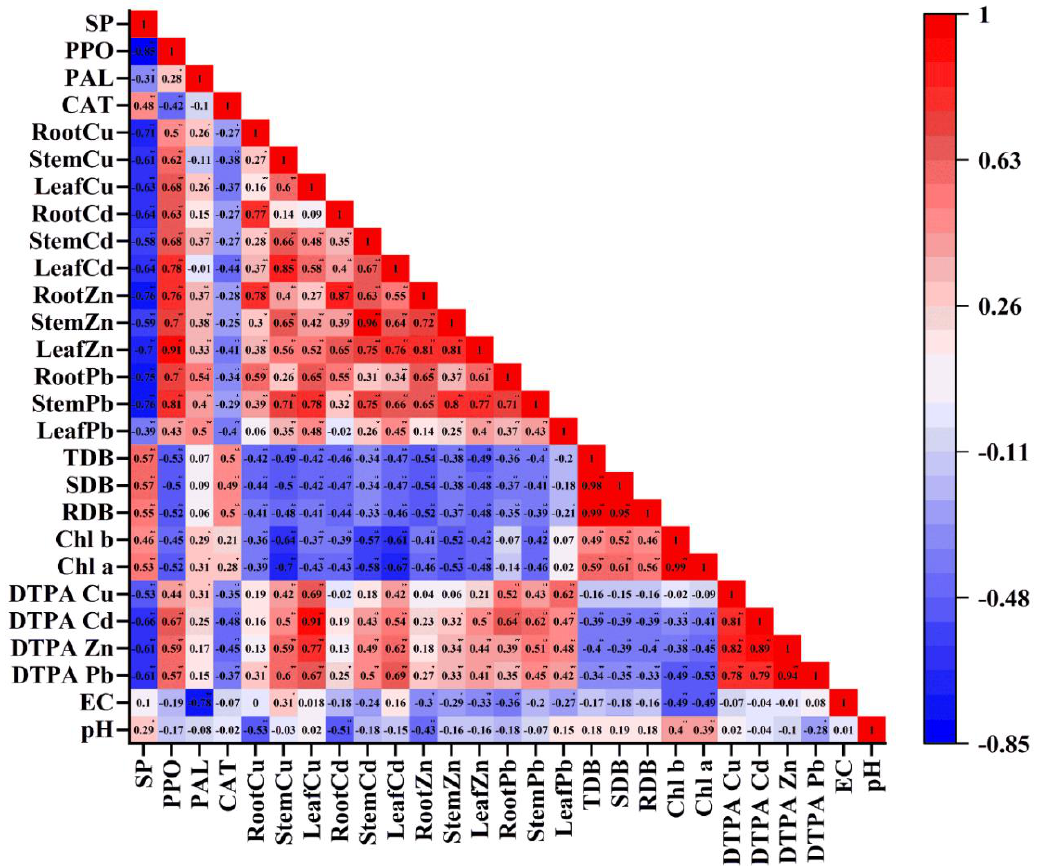
Figure 5. Pearson’s correlation test among tailings’ physicochemical properties, A. fruticosa growth, tissue metal concentrations and antioxidant enzyme activitiesafter harvesting.CK1: Control 1; CK2: